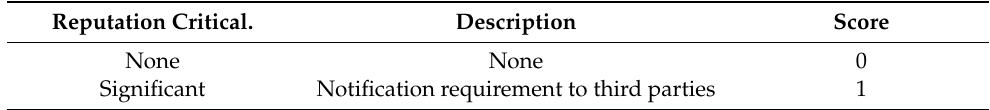
Table 8. Estimation criteria for reputational criticality. Reputation